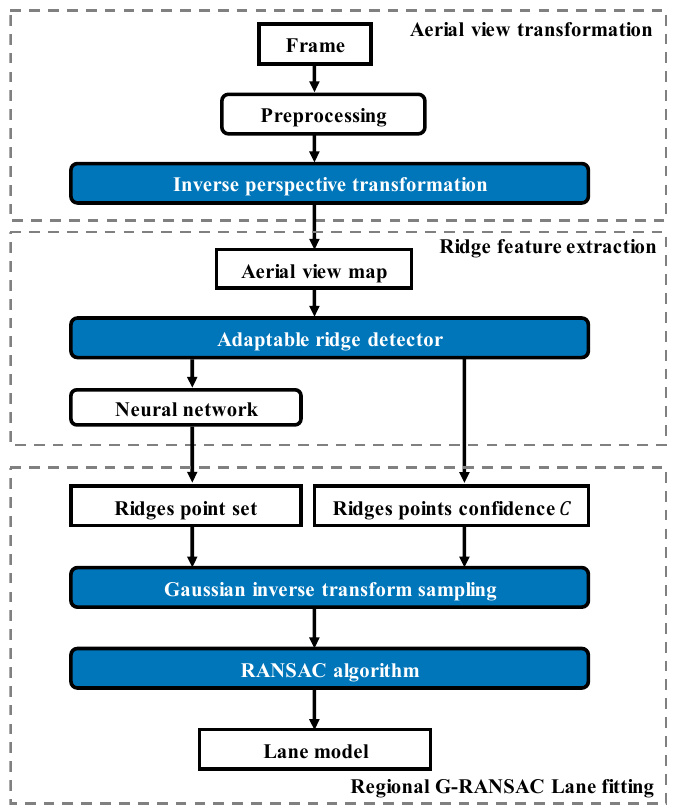
Figure 1. Detection algorithm block diagram.